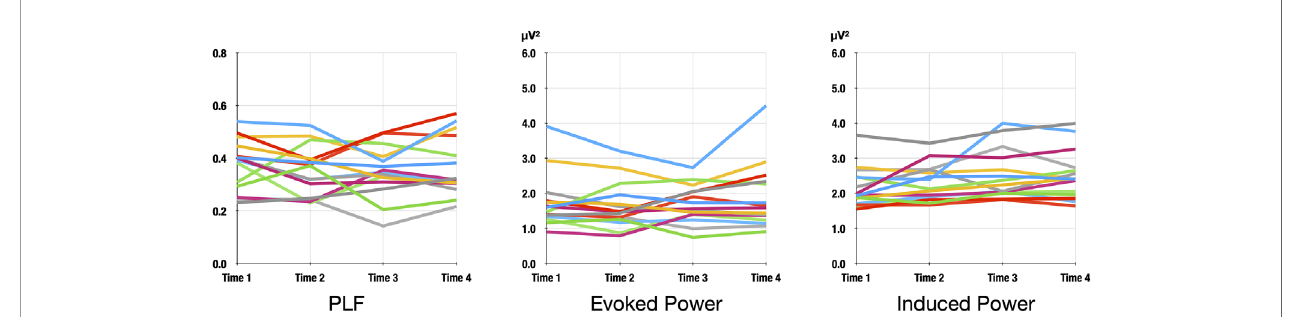
FIGURE 3 | Line plots of PLF, evoked power, and induced power at the four time